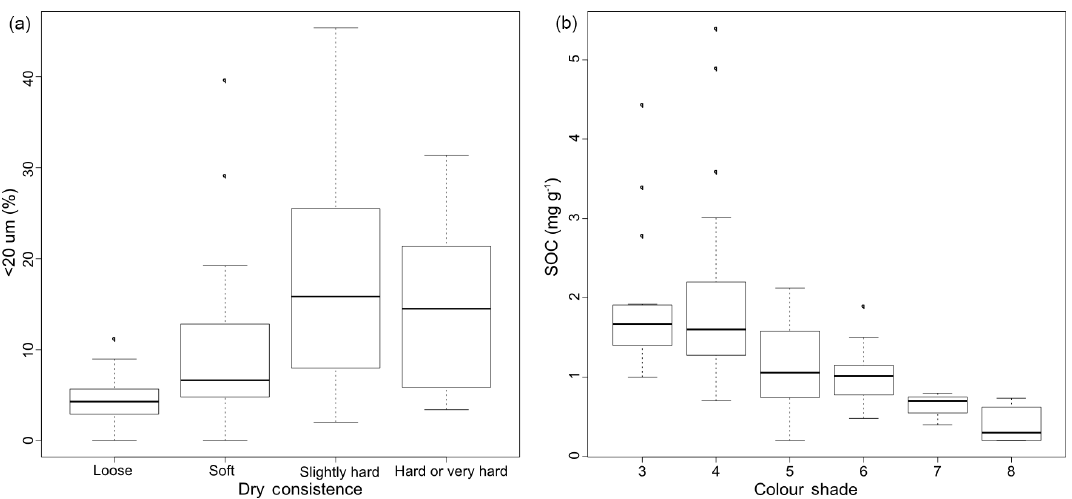
Figure 2. Box plot showing the relation between (a) fine particle ( < 20µm) content and soil consistence when dry and (b) soil organic content (SOC) and moist colour shade (Munsell colour value).